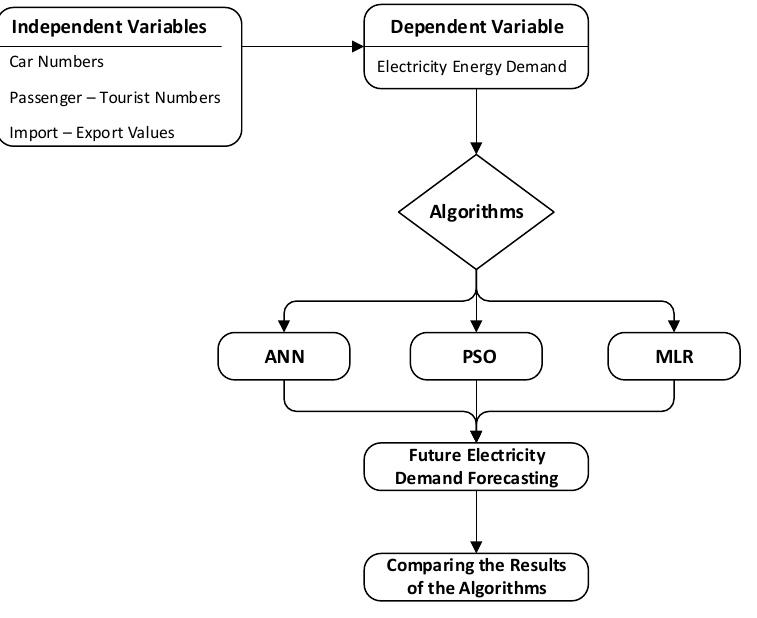
Figure 5. Machine learning framework proposed for forecasting electricity demand.